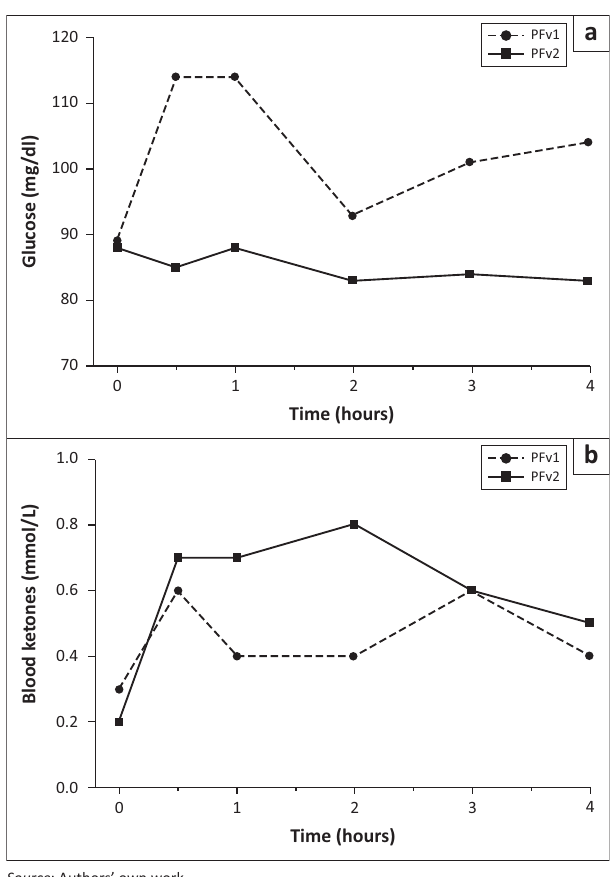
FIGURE 7: Glucose and BHB responses to PFv2. (a) In participant #4, who had displayed the greatest blood glucose response to PFv1, 25 g of PFv2 did not elevate blood glucose from a baseline of 88 mg/dl. (b) A greater BHB response was seen with PFv2 compared to PFv1. After 25 g of PFv2, BHB increased by 0.5 mmol/L from 0.2 mmol/L at baseline to 0.7 mmol/L after 30 min, reached a peak of 0.8 mmol/L at 2 h and remained above 0.5 mmol/L for the whole study